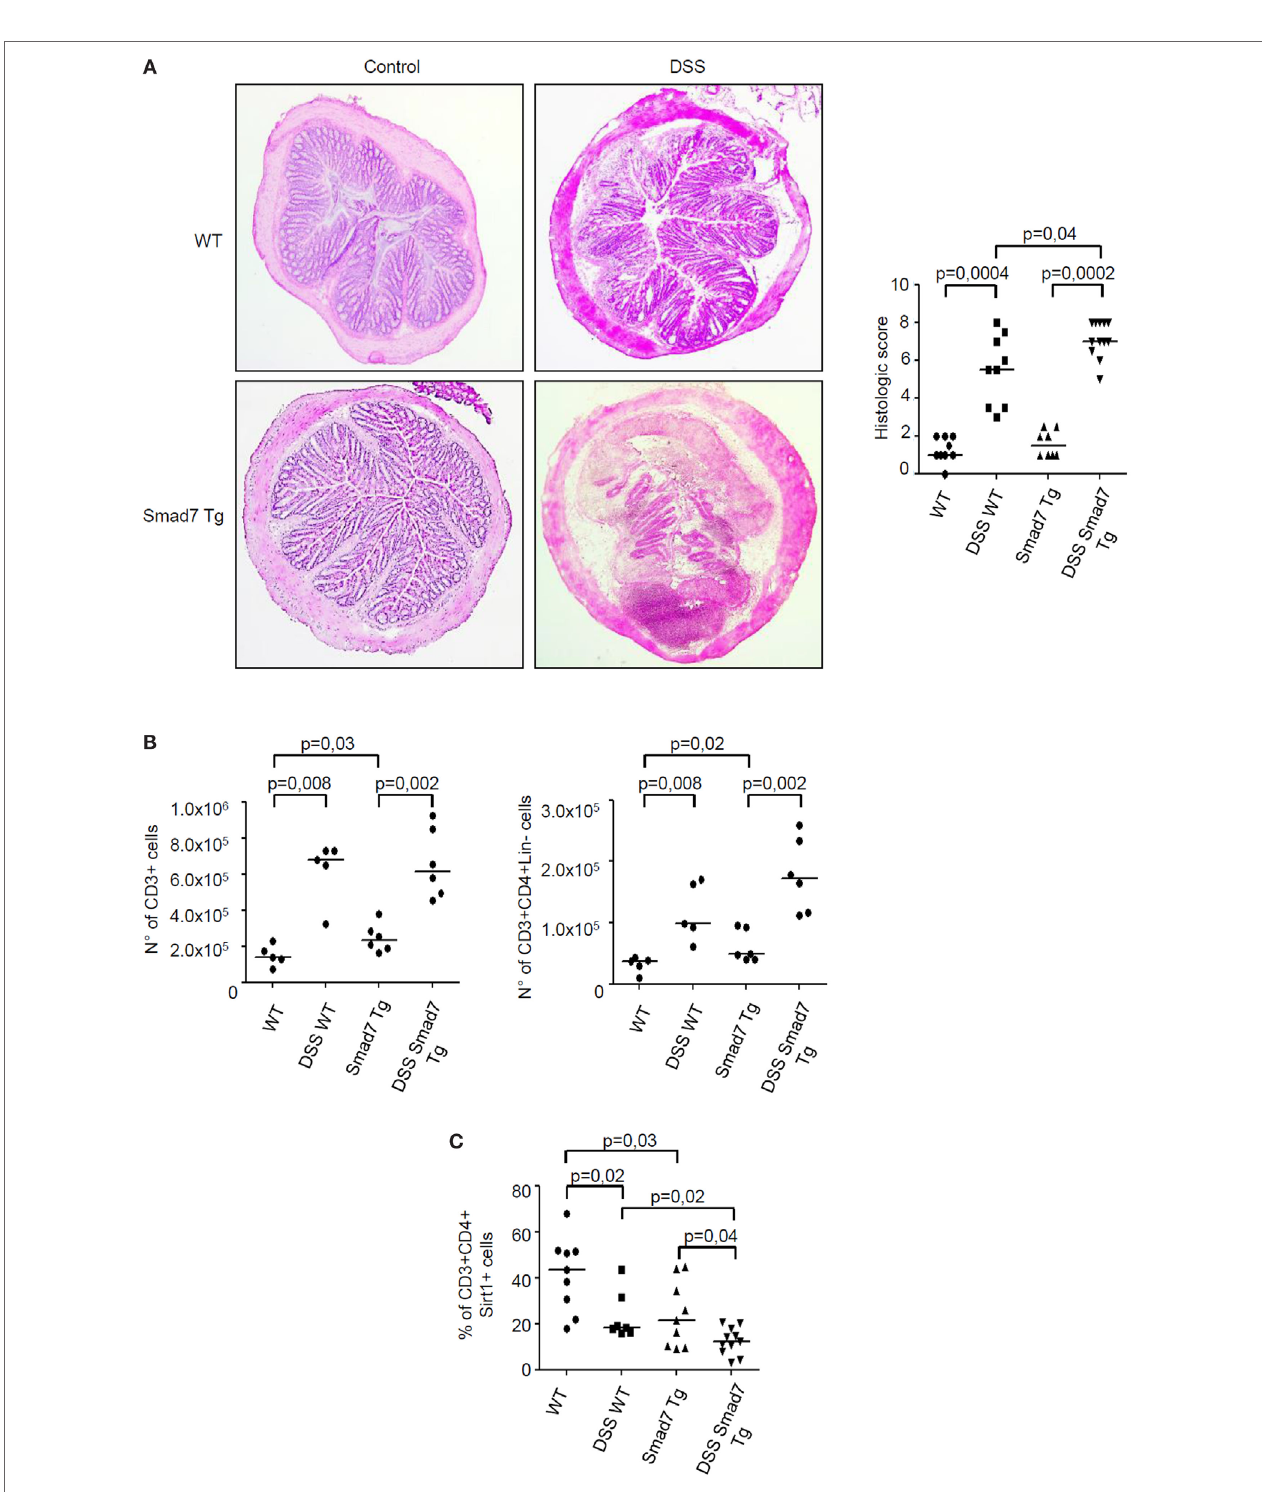
FigUre 6 | Sirt1 expression is reduced in the colon of mice overexpressing Smad7 in T cells. (a) Photomicrographs (50 × original magnification) of hematoxylin and eosin-stained colonic sections taken from wild-type (WT) mice and Smad7 transgenic (Tg) mice treated or not treated with dextran sulfate sodium (DSS). Right panel shows histological score of the colon sections taken from WT and Tg mice either treated or not with DSS; each point in the graph indicates the histological score in the colon of a single mouse; horizontal bars indicate the median values. (B) Number of CD3 + cells (left panel) and CD3 + CD4 + Lin − cells (right panel) in the colons of mice treated as above. Lamina propria mononuclear cells (LPMC) were isolated from colonic samples, counted, and analyzed by flow cytometry. Each point in the graph indicates the number of positive cells in the colon of a single mouse; horizontal bars indicate the median values (c) . Percentage of Sirt1-expressing CD3 + CD4 + LPMC isolated from colonic samples of mice treated as above and analyzed by flow cytometry; horizontal bars indicate the median